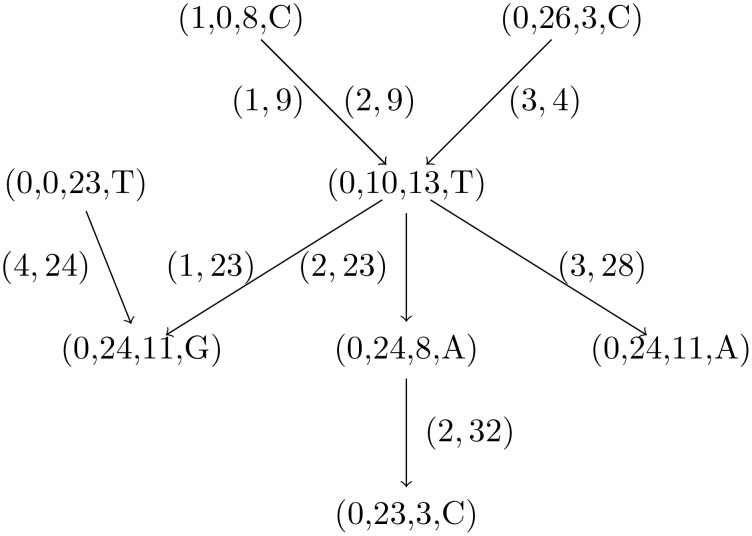
RME graph for the sequences from Example 1.The graph has 8 nodes and 8 edges. The edge from (1,0,8,C) to (0,10,13,T) occurs two times: one time for the factorization of s
1 and another time for the factorization of s
2.